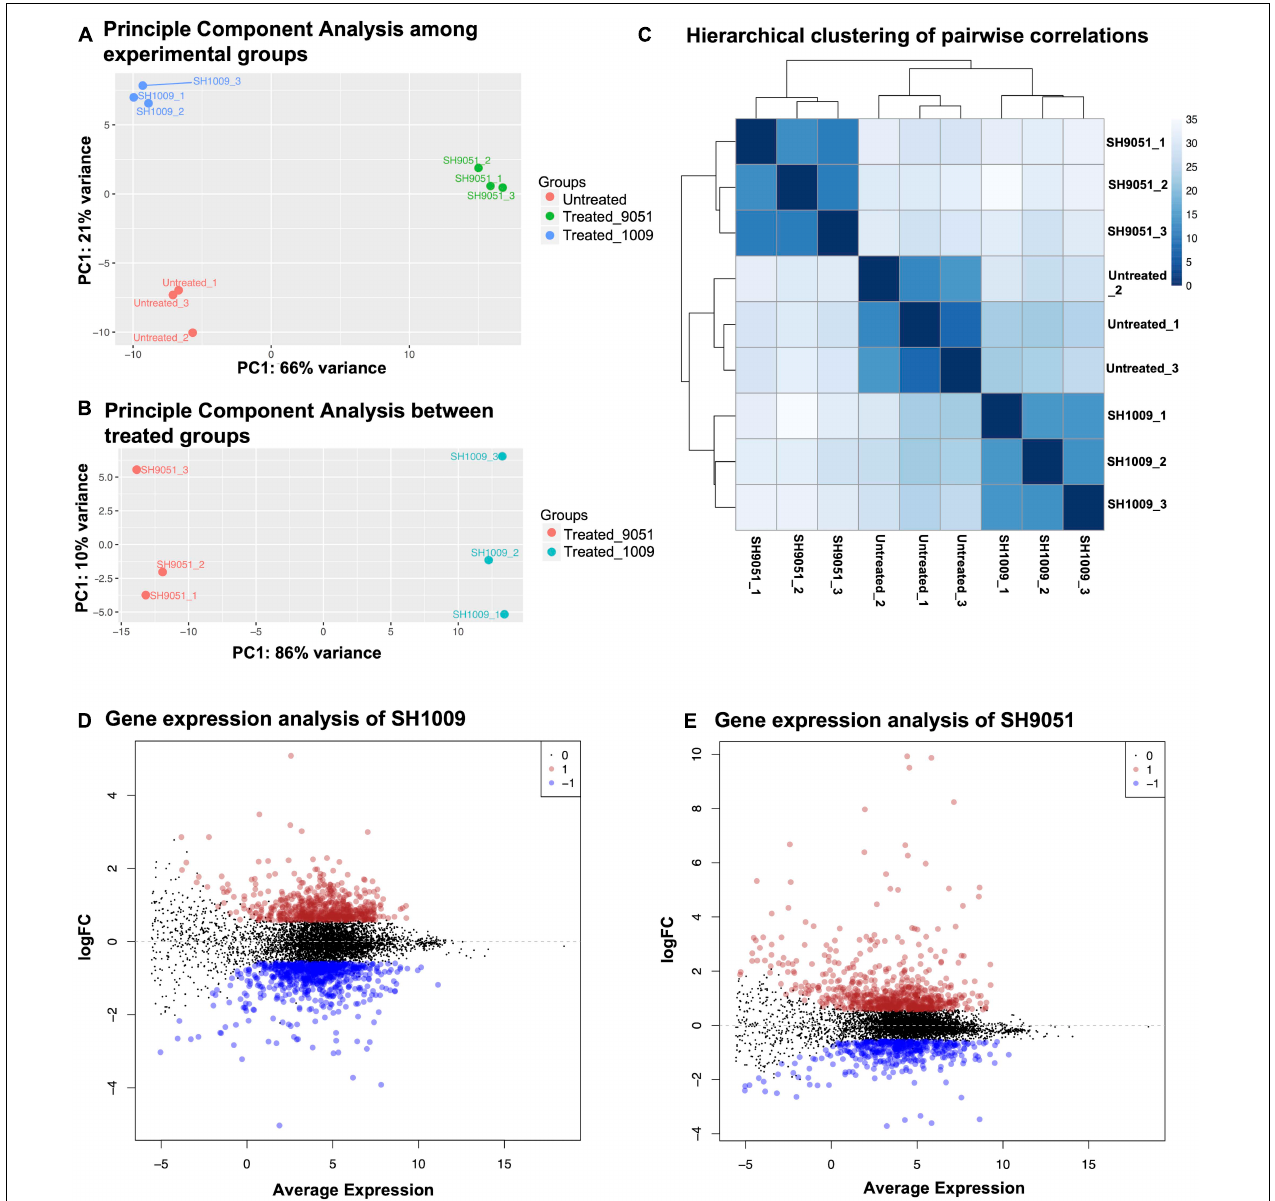
FIGURE 2 | The reproducibility and differential expression analyses of RNA-seq data for SH1009-treated, SH9051-treated, and untreated C. albicans samples. (A,B) The principal component analysis plots of log-transformed counts where the x -axis represents the first dominant principal component (PC1) to measure the variance between experimental conditions and the y -axis represents the second dominant principal component (PC2) to measure the variance among the replicates within each sample. (C) Hierarchical clustering with heatmap to measure sample-to-sample distances where the depth of the blue color indicates the correlation values. (D,E) The mean dot (MD) plots of the log (fold change ≥ 1.5) for statistically significant genes (FDR ≤ 0.05) that are up-regulated (red dots) and down-regulated (blue dots) after 1 h exposure to aurones SH1009 and SH9051,